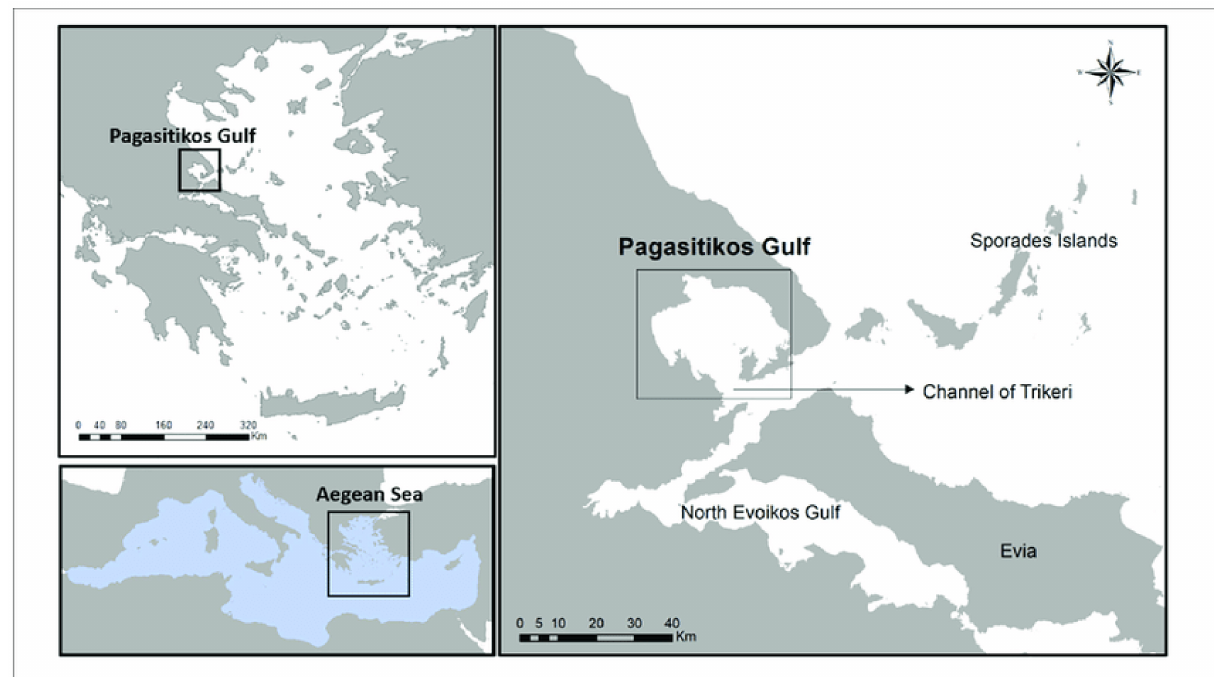
Figure 1. Study area of the 34 collected questionnaires from small-scale fishermen in the harbor of the city of Volos, Pagasitikos Gulf, central Greece after